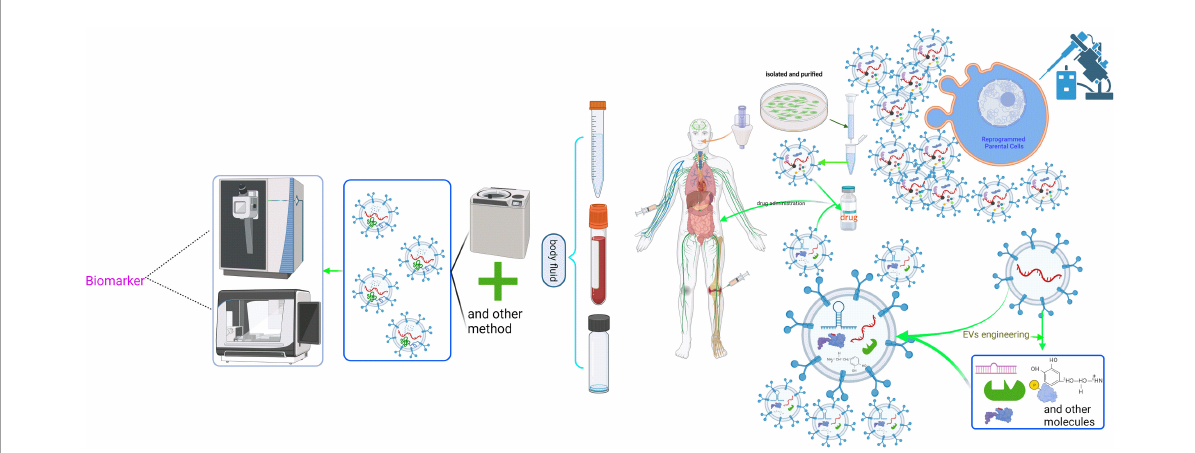
FIGURE4 Schematic representation of the clinical application of neuronal EVs. The cargoes in EVs are derived from the parental cells, which partly reflect the physiological or pathological state of the donor cells. Moreover, EVs can effectively protect their contents from being degraded by various enzymes in body fluids, prolonging the half-life of various biomarkers. Therefore, isolating and purifying EVs from body fluids using various methods, including ultracentrifugation, and then analyzing and studying them are of great significance for predicting the state of cells. However, clinical application of EVs is still quite difficult because there is no effective method to purify EVs from a defined cell. Additionally, based on the physical and chemical characteristics of EVs, such as the ability to pass the blood-brain barrier, EVs can package some targeted drugs via genetic manipulation to deal with